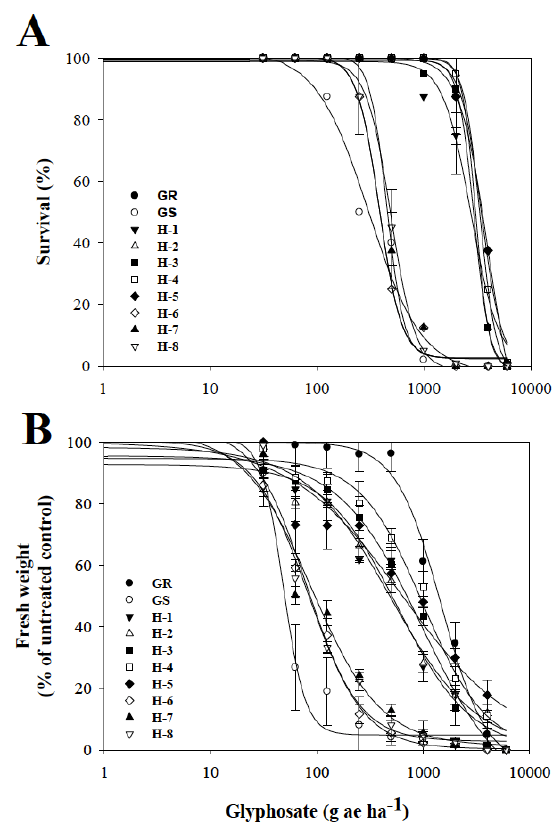
Figure 1. Glyphosate dose–response on ( A ) survival and ( B ) fresh weight reduction expressed as a percentage of the mean untreated control of the populations of C. canadensis from Spain (GR and GS) and Hungary (H1–H8). Symbols denote the mean ( n = 15) ± standard errors.